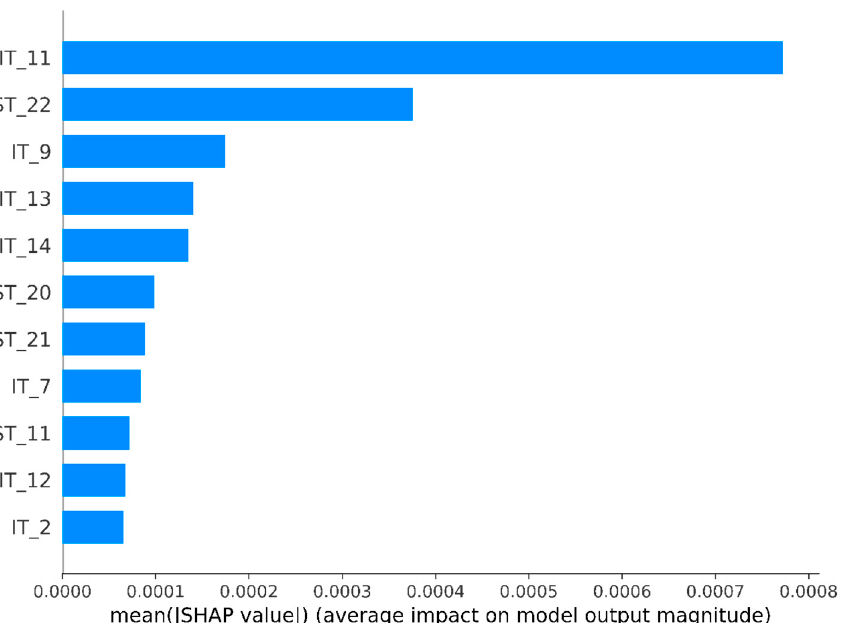
Figure 14. Feature importance at the input to PIDNN, ranked by SHAP values, for SKD system with LLC block based on optimal Huffman code over source alphabet of size 2 10 (system B).